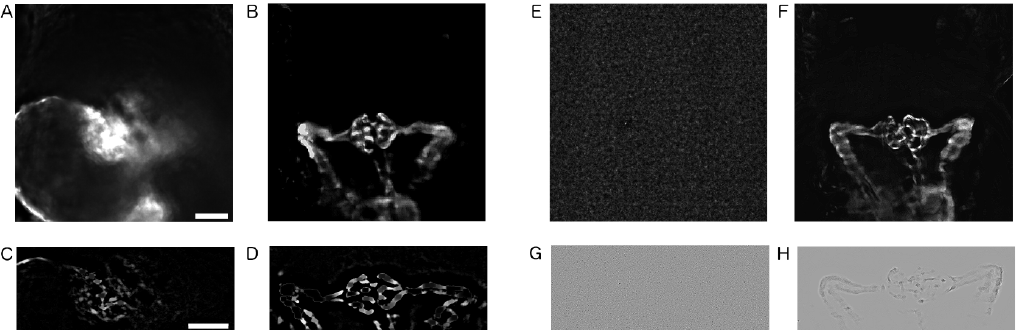
Figure 3. Quality control and image filtering. ( A – D ) Pre-processed images used for the quality